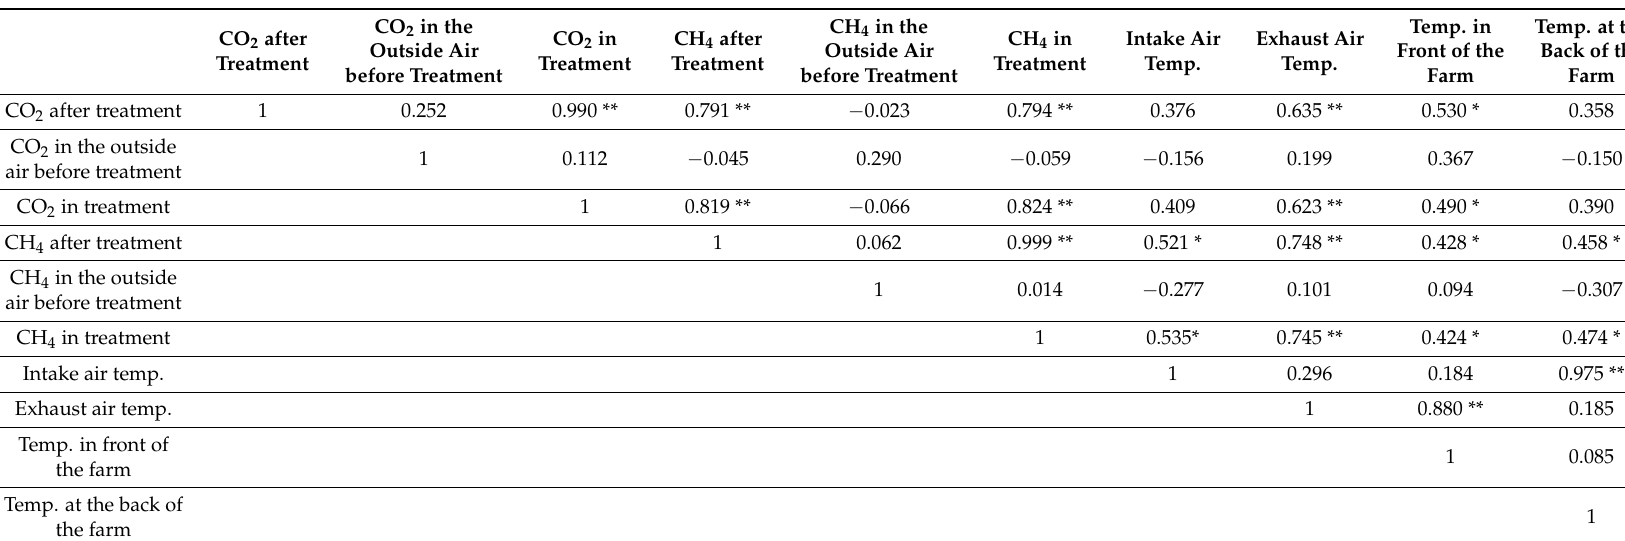
Table 7. Correlation Relationship among Comparative Factors in the Soil Treatment before and after the Swine Manure Mixing